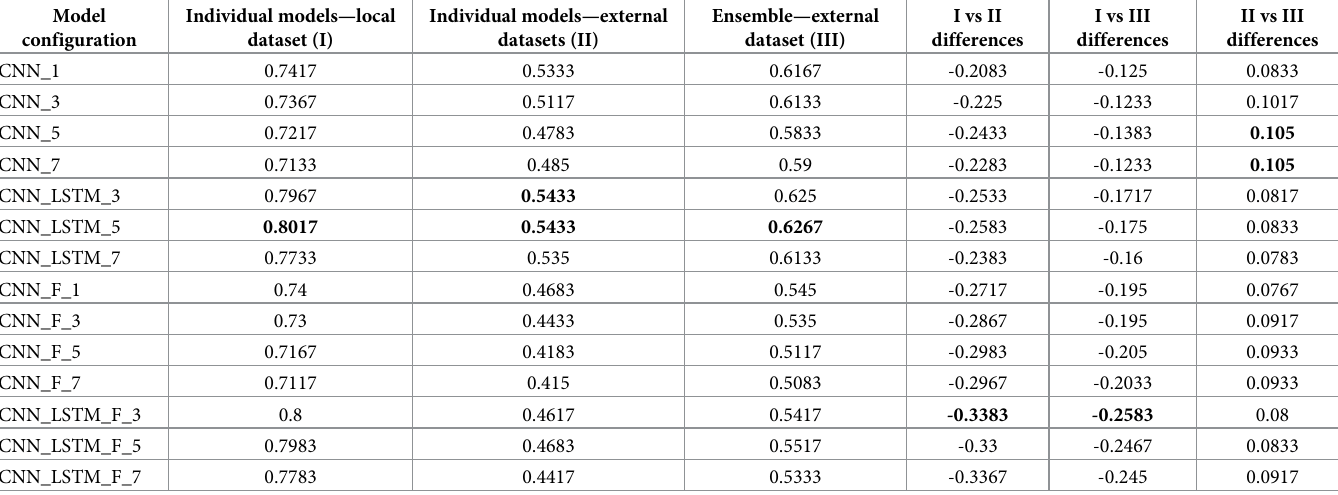
Table 4. Global performance comparison by aggregating results across all datasets. Model Individual models—local configuration dataset